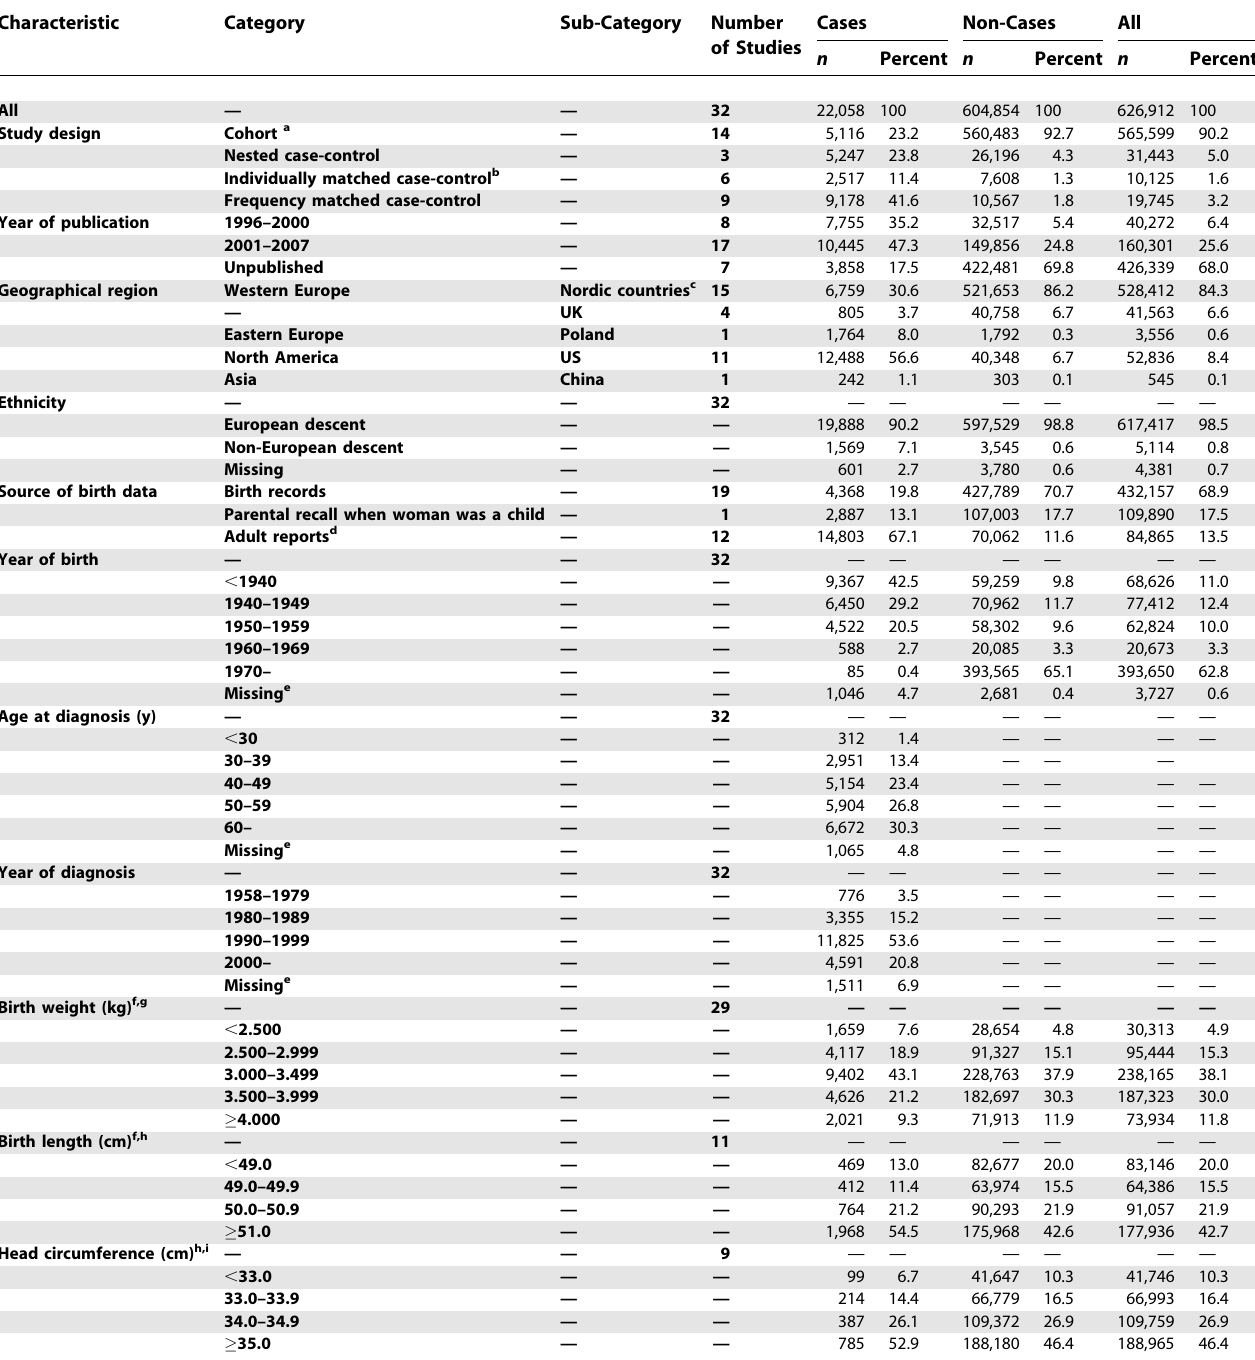
Table 1. Summary Characteristics of the 32 Participating Studies